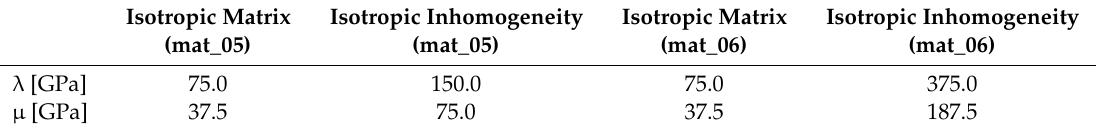
Figure 13. A typical discretized spherical model in the volume integral equation method (VIEM). ( a ) A spherical model; ( b ) an inside view of a spherical model. Table 5. Material properties of the isotropic matrix and the isotropic spherical inhomogeneity.